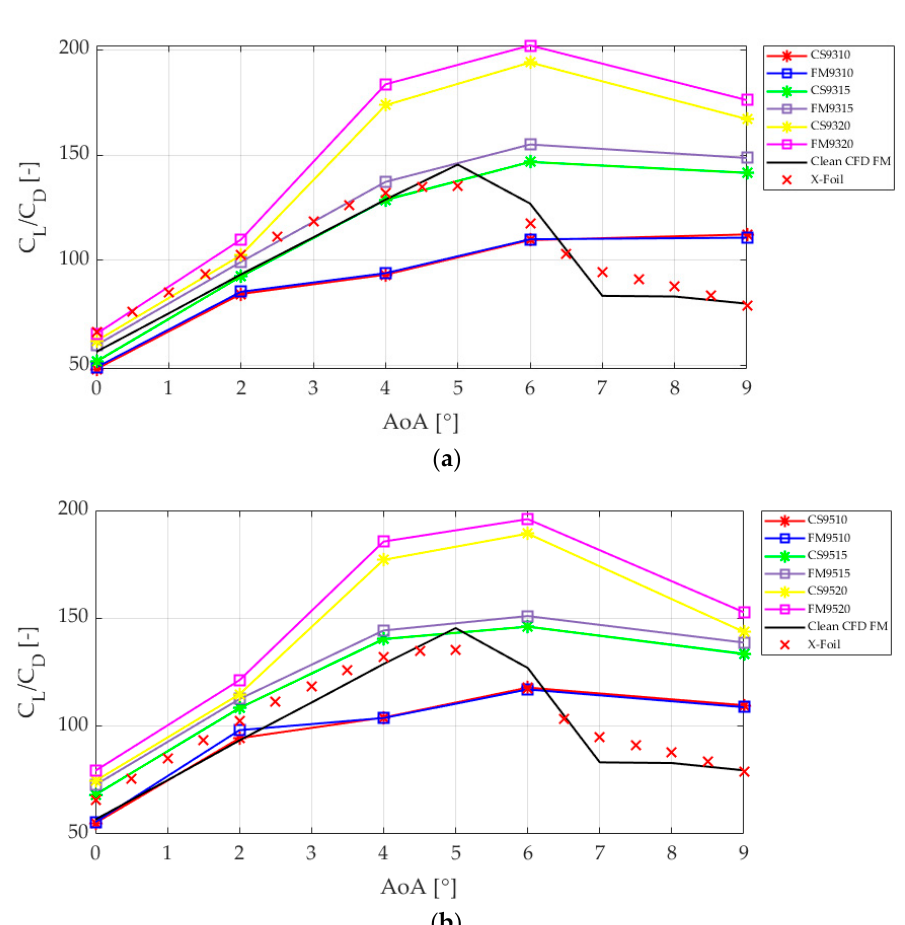
Figure 5. Aerodynamic performance curves (C L /C D , lift-to-drag ratio) for different MT lengths implemented on a DU91W(2)250 airfoil: ( a ) location of the MT at x = 93% of c and ( b ) location of the MT at x = 95% of c. AoAs range between 0 and 9°.